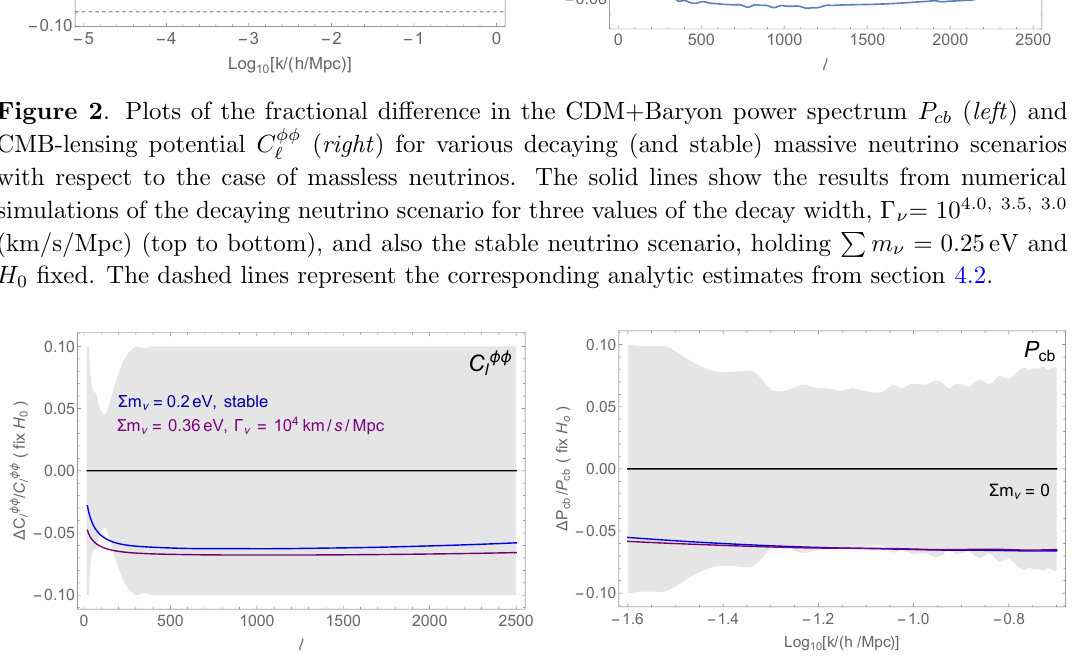
( left ), CDM+Baryon power ‘